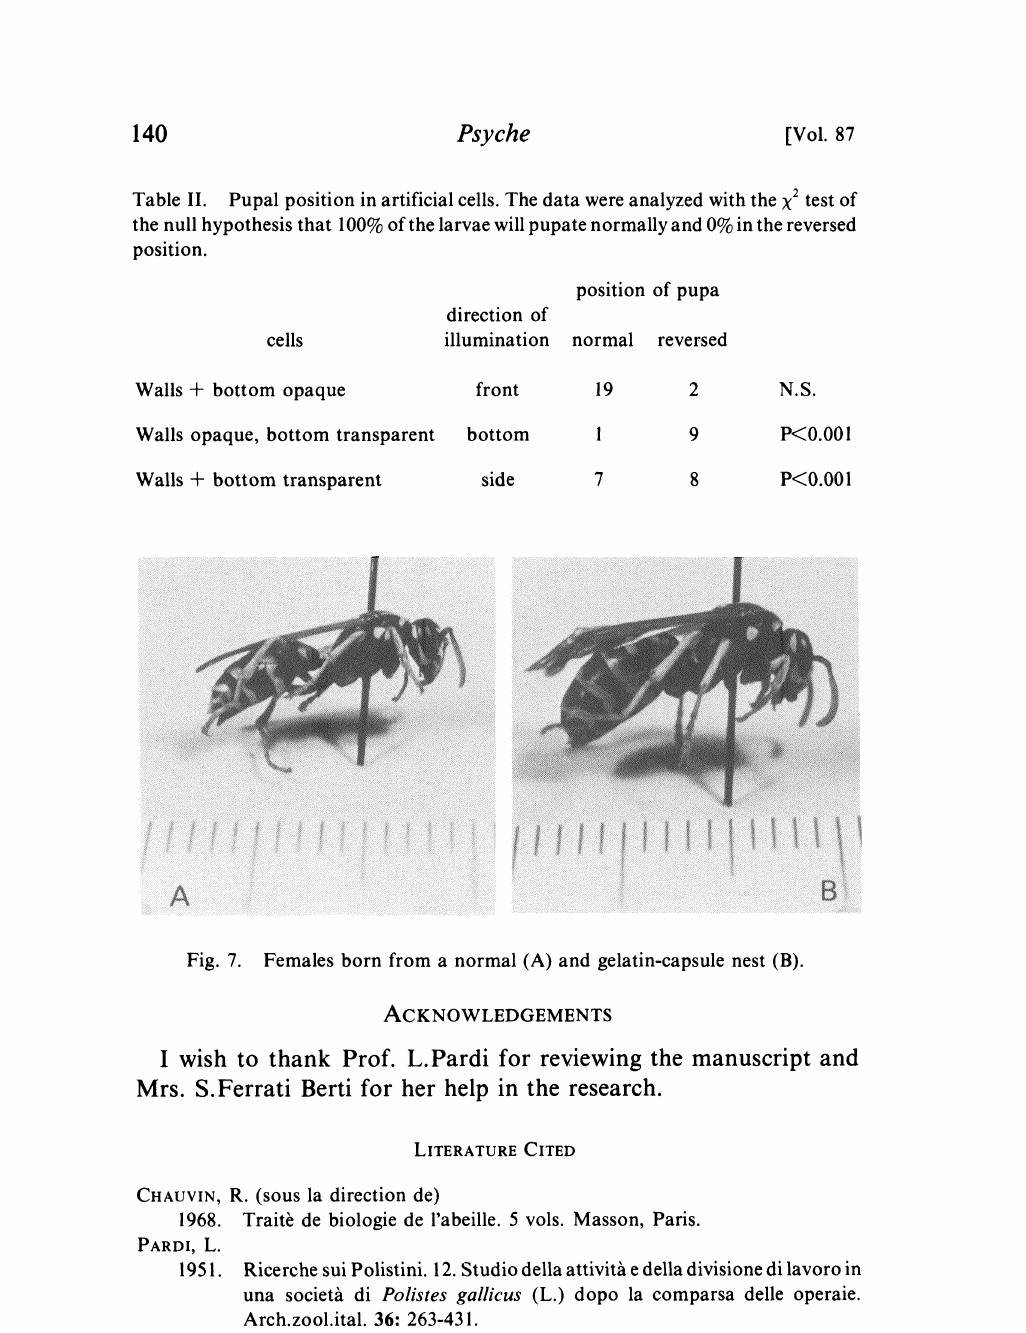
Table II. Pupal position in artificial cells. The data were analyzed with the X test of the null hypothesis that I00% ofthe larvae will pupate normally and 0% in the reversed position.